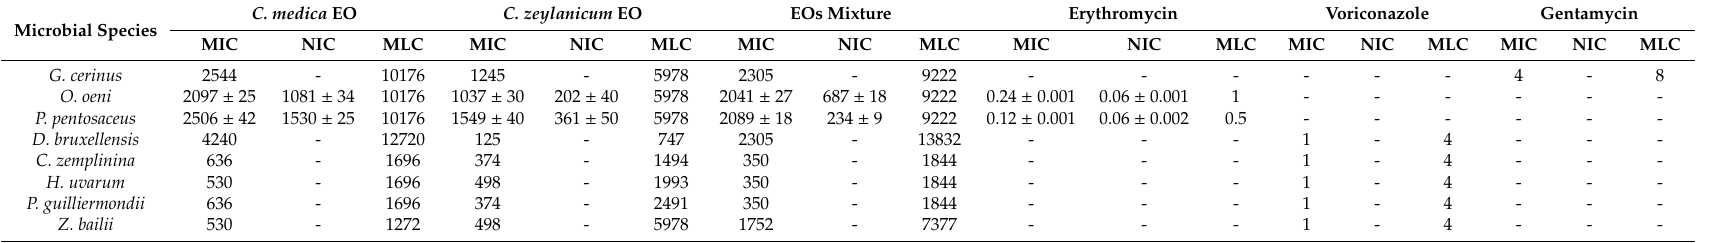
Table 2. Minimum inhibitory (MIC), non-inhibitory (NIC) and minimum lethal concentration (MLC) (mg / L) of Citrus medica and Cinnamomum zeylanicum EOs and their mixtures against common wine spoilage microbes. Erythromycin was used as positive control for Oenococcus oeni and Pediococcus pentosaceus , gentamycin for Gluconobacter cerinus and voriconazole for yeasts (standard deviation ranged in zero values if not shown). Application of the Lambert–Pearson model (LPM) and thus NIC determination for Gluconobacter cerinus , Dekkera bruxellensis , Candida zemplinina , Hanseniaspora uvarum , Pichia guilliermondii and Zygosaccharomyces bailii was impossible, due to the high turbidity of G. cerinus culture broth (“milky” e ff ect) and yeast cell